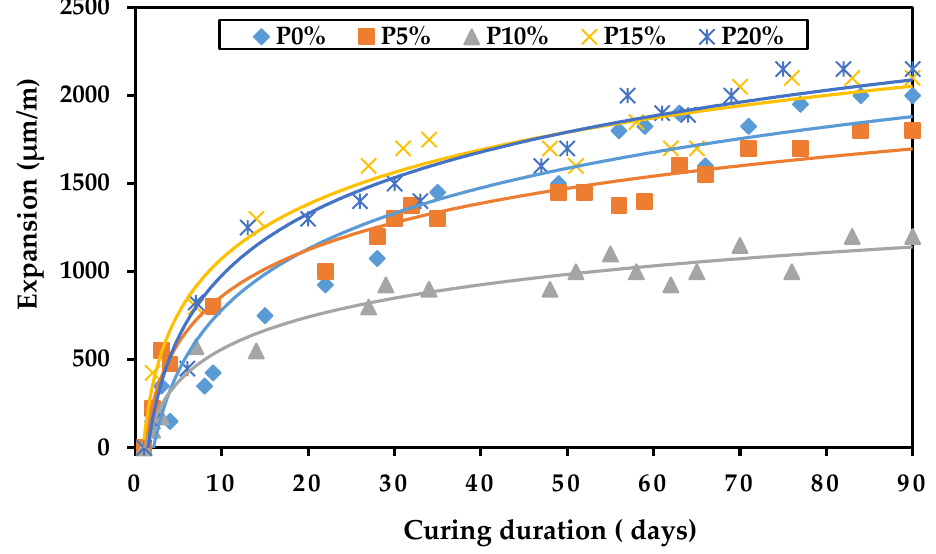
Figure 9. Expansion of pastes with different percentages of LF.